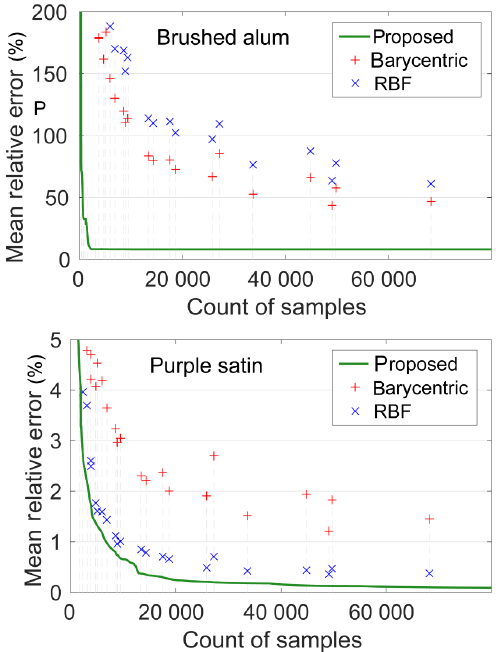
Fig. 8 MRE as a function of the number of samples for two materials.